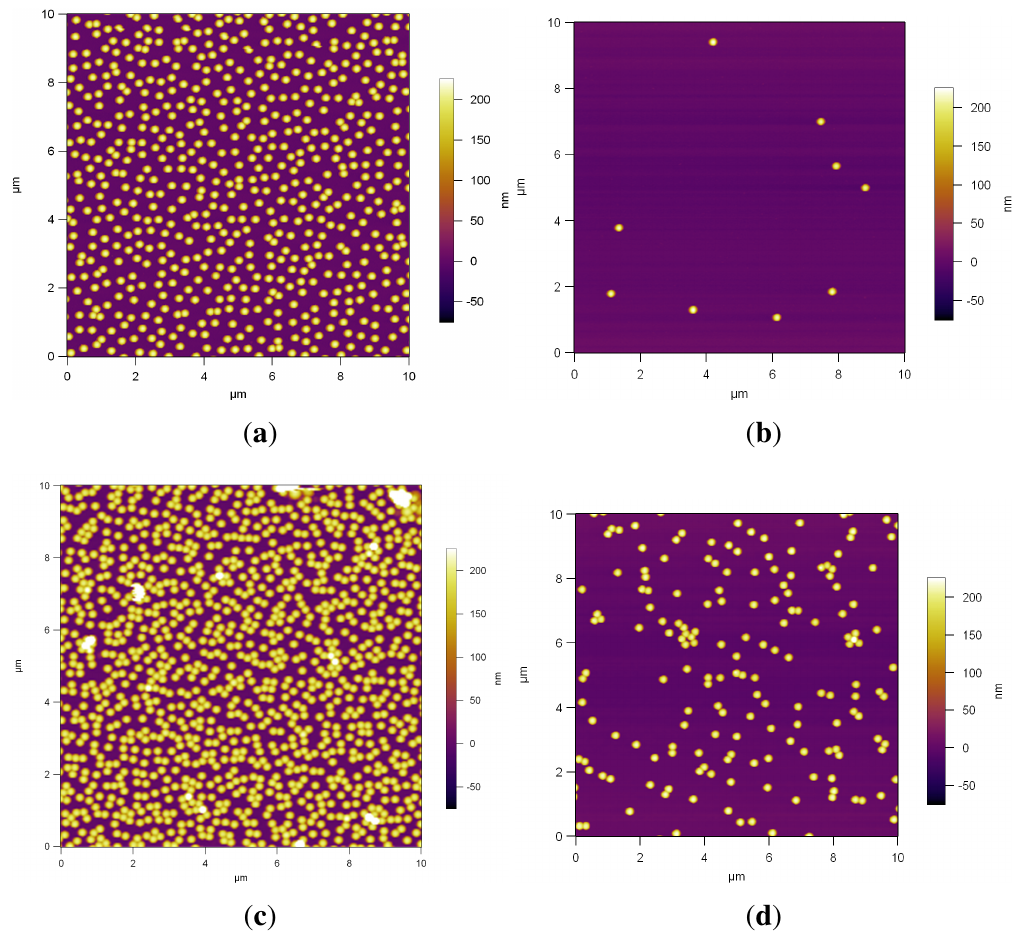
Figure 9. AFM height profiles of PS NP monolayer obtained from spin-coating at 2000 rpm (Left) and 5000 rpm (Right), on, Si/PEI/(PSS/PAH) and ( d ); quaternized PDMAEMA brushes ( e ) and ( f